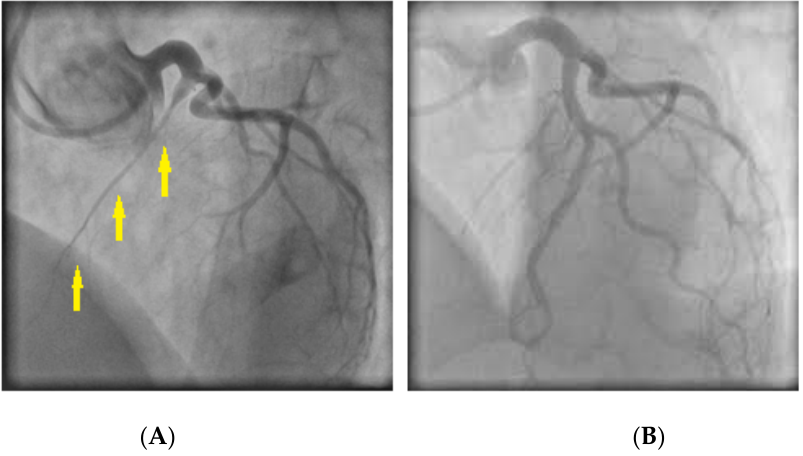
Figure 4. ( A ) Coronary angiography revealing spasm in the right coronary artery (arrows); ( B ) Response of the stenotic region to intracoronary nitroglycerin administration.